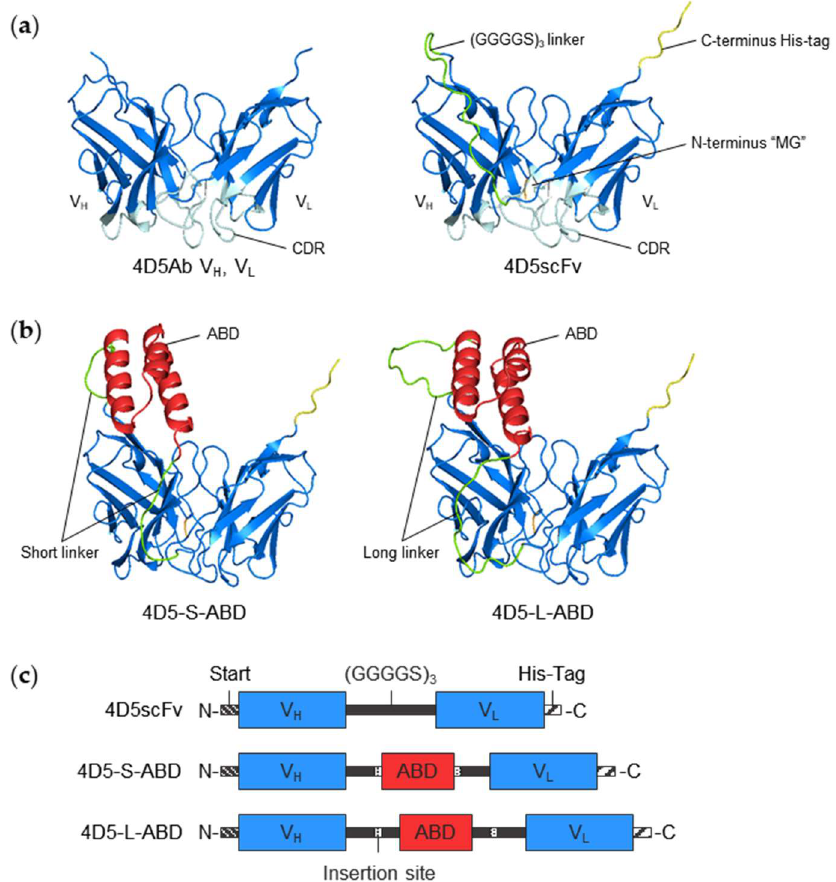
Figure 1. ( a ) Structures of V H and V L region of 4D5Ab (PDB ID:1FVC [14]) and model structure of designed 4D5scFv predicted by AlphaFold2. N-terminus is close to CDR, whereas C-terminus and internal linker are far away from it ( b ) Model structures of two 4D5-ABD variants. Inserted ABD is located away from CDR (blue: V H and V L region; light blue: CDR; green: internal (GGGGS) 3 linker; orange: “MG” start restriction sequence at N-terminus; yellow: His-tag at C-terminus; red: ABD). All model structures were visualized by PyMOL. ( c ) Schematic diagram of composition of 4D5scFv and two 4D5-ABD variants.